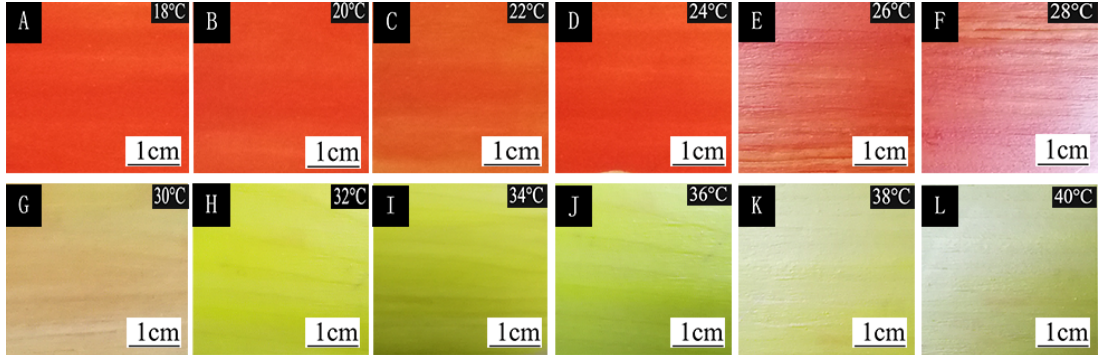
Figure 6. Coating images of the orthogonal test: ( A – D ) the images of Samples #1–#4 at 18 ◦ C; ( E – H ) the images of Samples #1–#4 at 32 ◦ C.